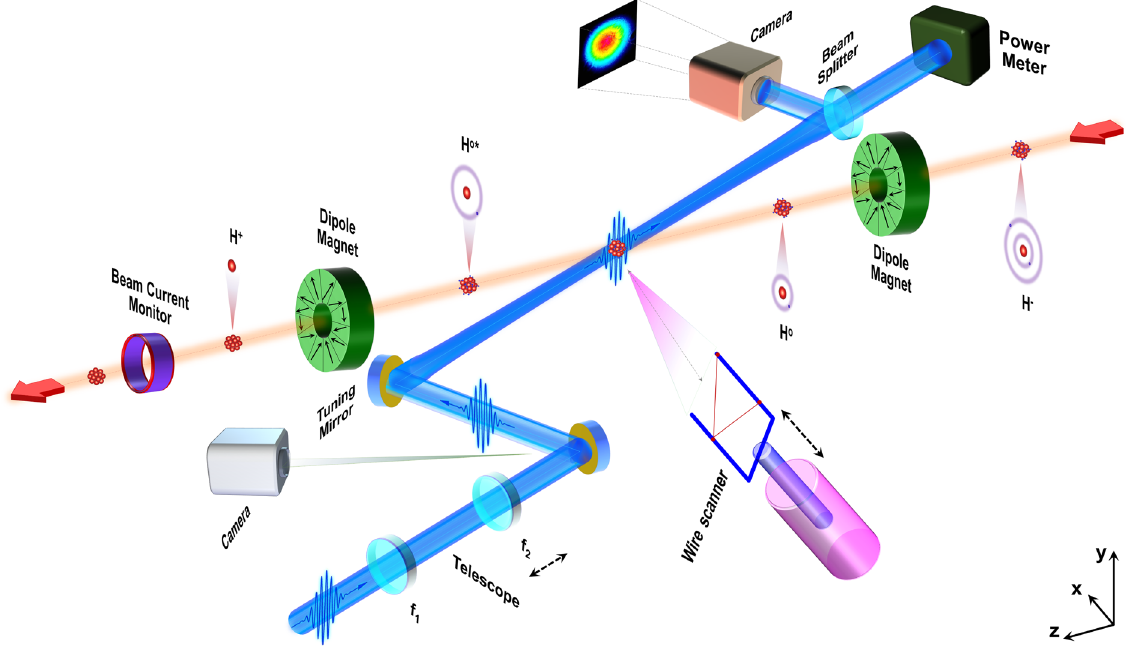
FIG. 22. Schematic of the experimental layout shows three-step charge exchange injection concept along with the laser and ion beam configurations and the instruments for diagnostics during the